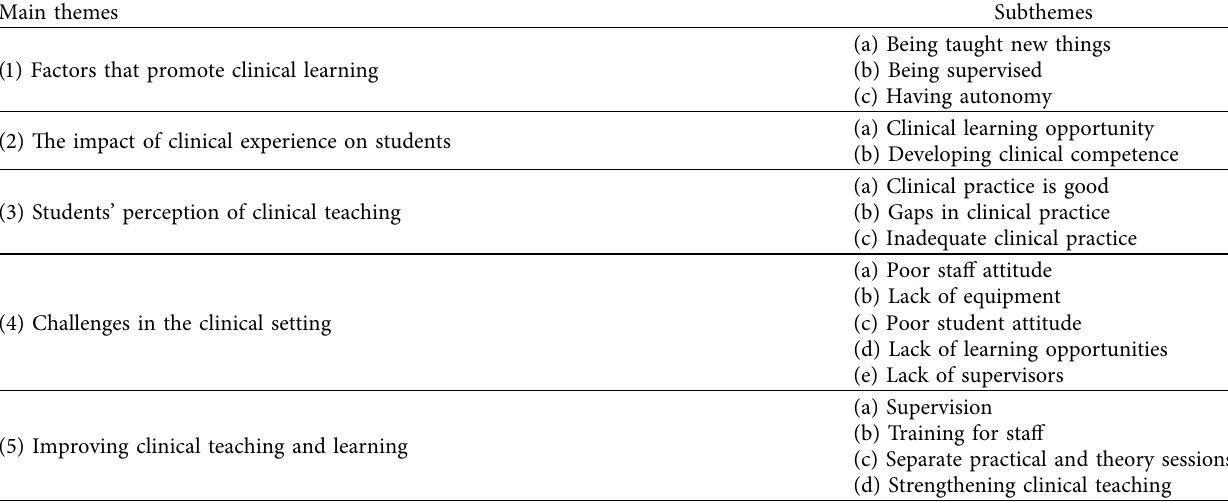
Table 2: Themes and